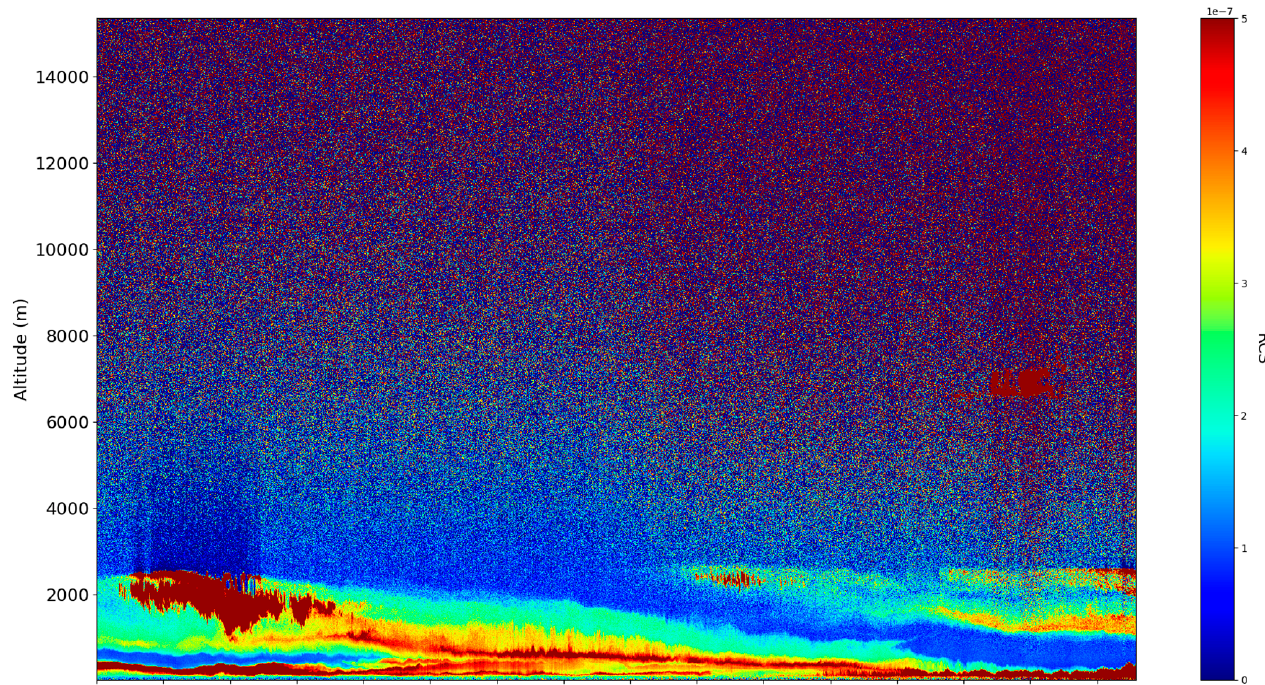
Figure 14. Zoomed-in (region of interest) RCS time series, λ = 1064 nm , Gala ț i, Romania, 23 De- cember 2021.